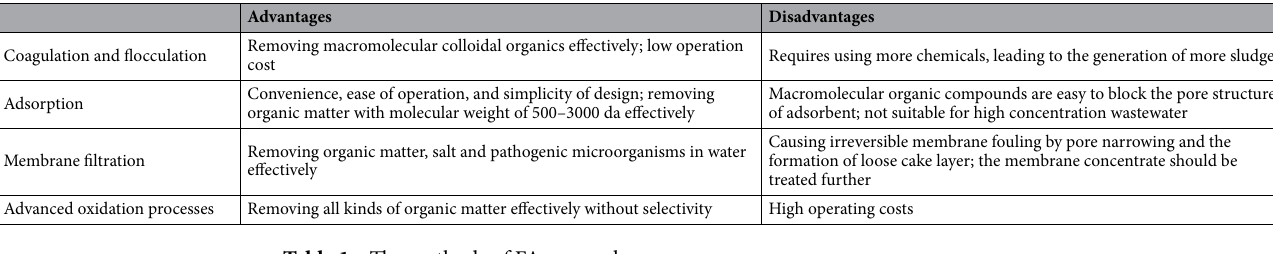
Table 1. The methods of FA